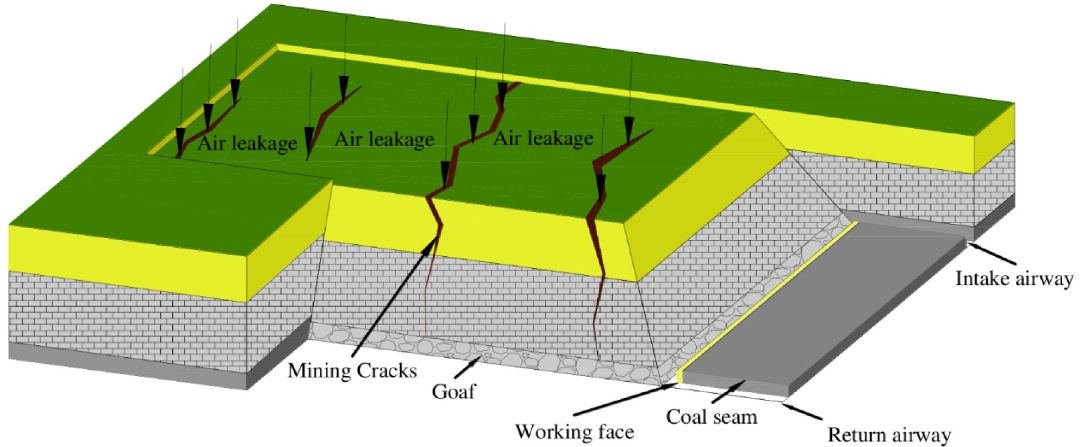
Fig 1. Air leakage from surface mining fractures in the 6104 working